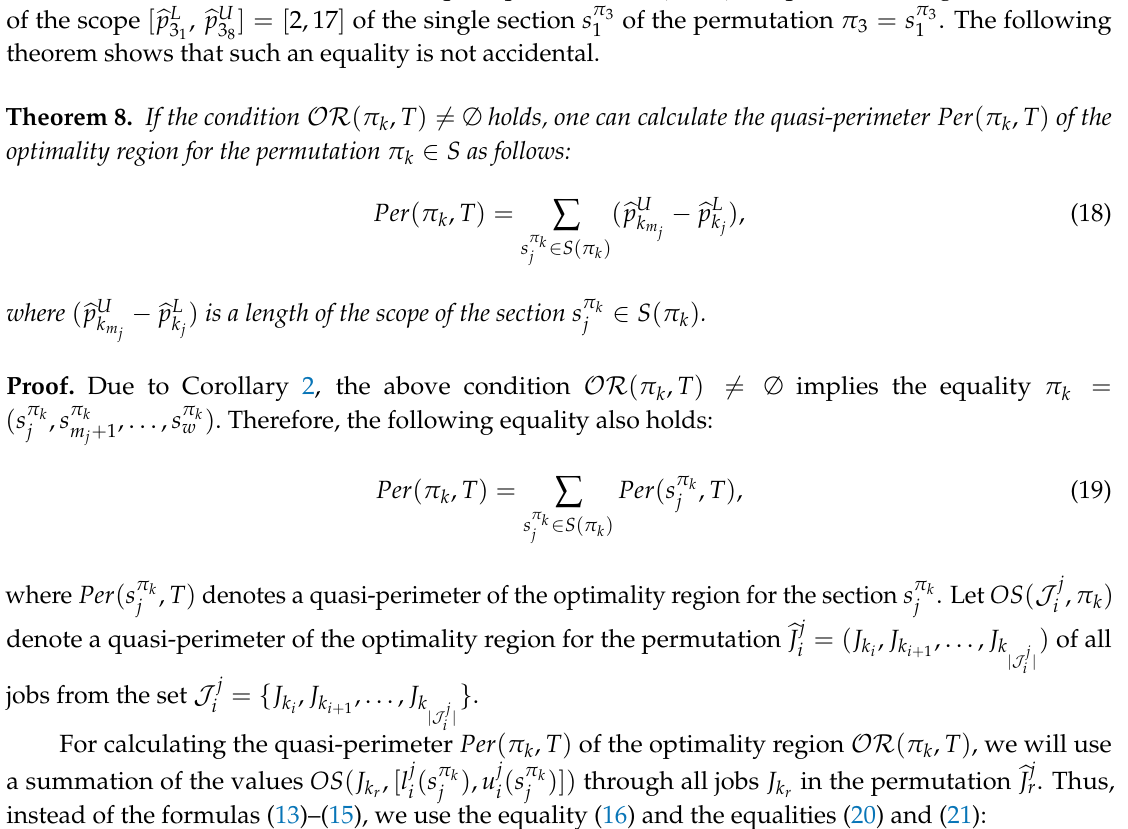
[ l 1 )] (cid:98) J 1 } = PCO{ J , u 1 1 k 1 k 1 1